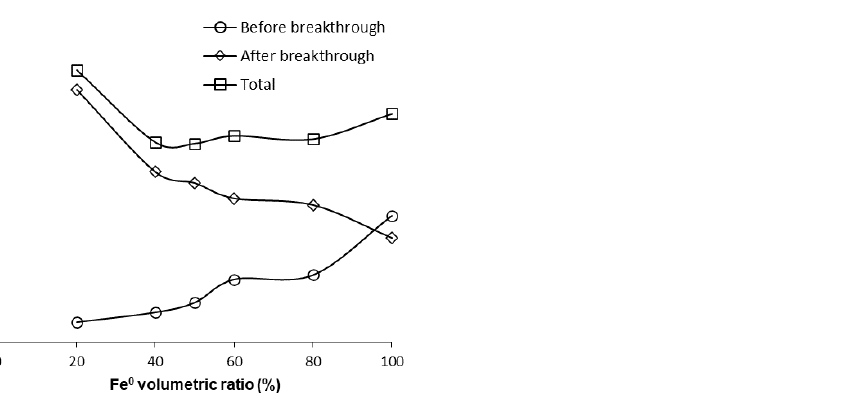
Figure 14. Cr VI removal capacity of Fe 0 for columns having variable Fe 0 volume and fixed total volume V 2 .